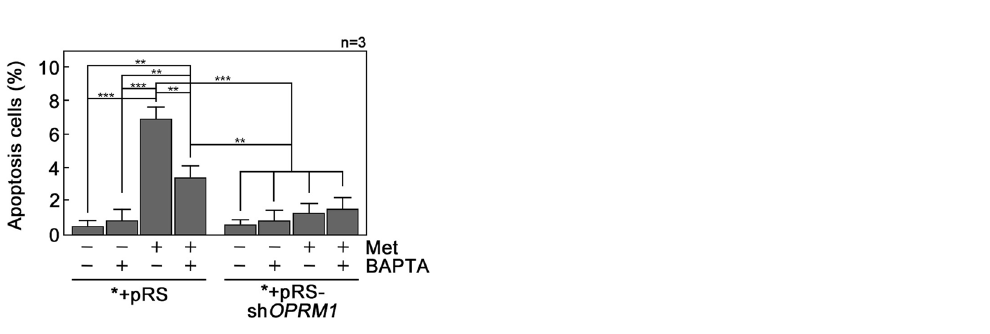
Figure 5. d,l-Methadone-induced apoptosis is reversed by Ca 2+ chelation with BAPTA-AM. *+pRS and *+pRS- sh OPRM1 cells pre-treated or untreated with 50 μM BAPTA-AM (BAPTA) for 30 min then treated or untreated with 0.5 μg/ml d,l-methadone for 12 h were stained with PI and FITC-Annexin V and subjected to flow cytometry as described in Materials and Methods. Values are means ± SEM from three independent experiments (n = 3). ** p < 0.01 and *** p <